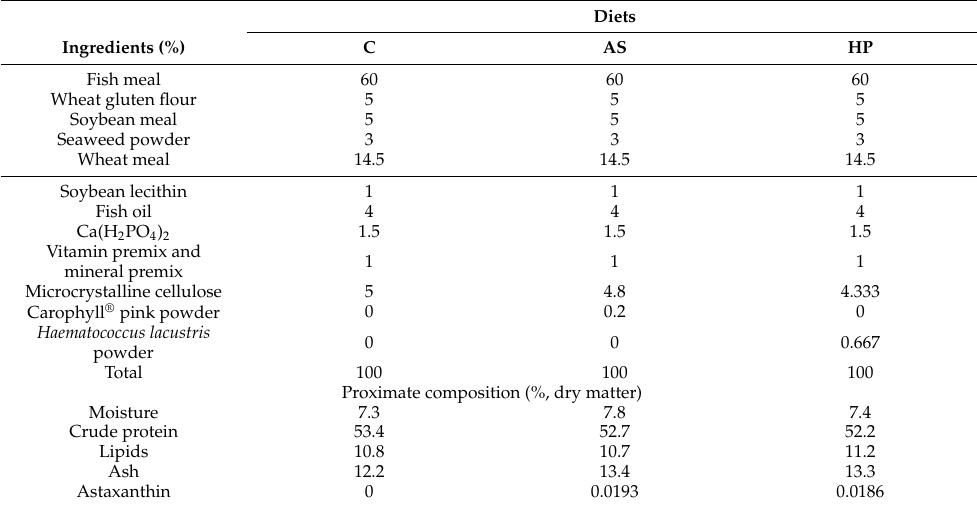
Table 1. Ingredients and proximate composition of the experimental